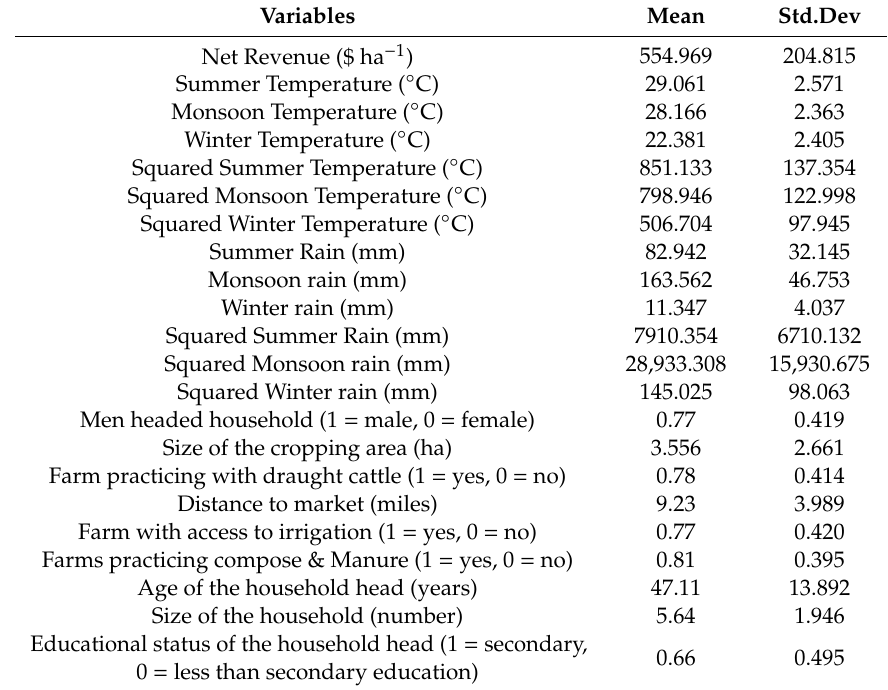
Table 1. Descriptive statistics: Variables for net revenue regression